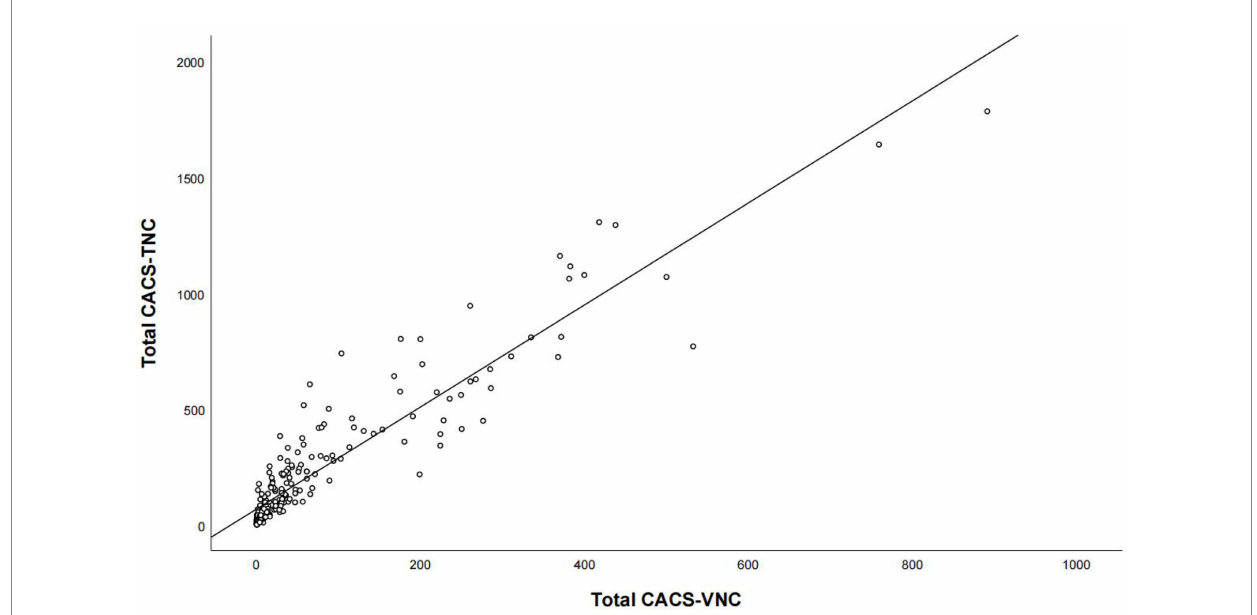
FIGURE 3 The correlation analysis for the overall calcium score between the conventional non-contrast and virtual non-contrast images. Total CACS-VNC represents the overall coronary artery calcium score from the virtual non-contrast images, and total CACS-TNC represents the overall coronary artery calcium score from the non-contrast images.